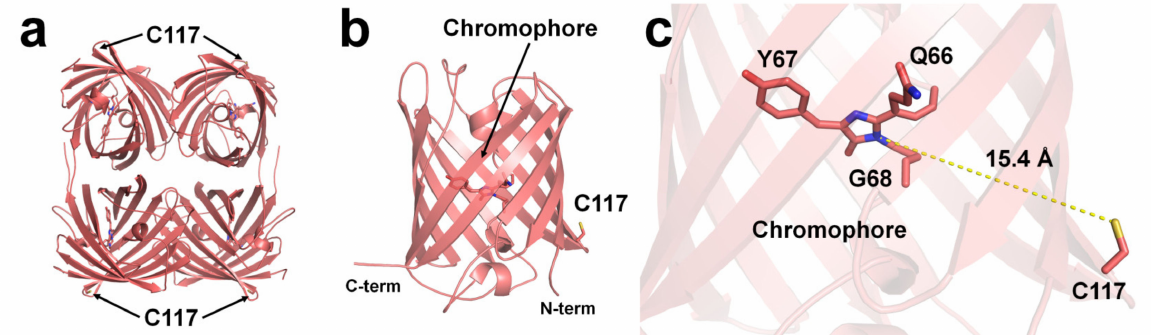
Figure 3. The Cu 2+ -binding site of DsRed (PDB code 1GGX). The position of Cu 2+ -binding Cys117 residue on the surface of β -can of ( a ) tetrameric and ( b ) monomeric DsRed. The Cu 2+ -binding site is identified based on chemical modification and spectral analysis. ( c ) The average distance between the imidazoline ring of the chromophore and Cys117 in DsRed was 15.4